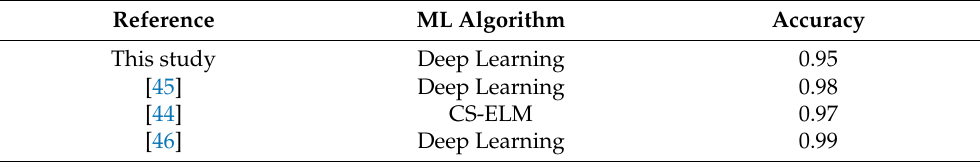
Table 3. Machine Learning-based methods for fault